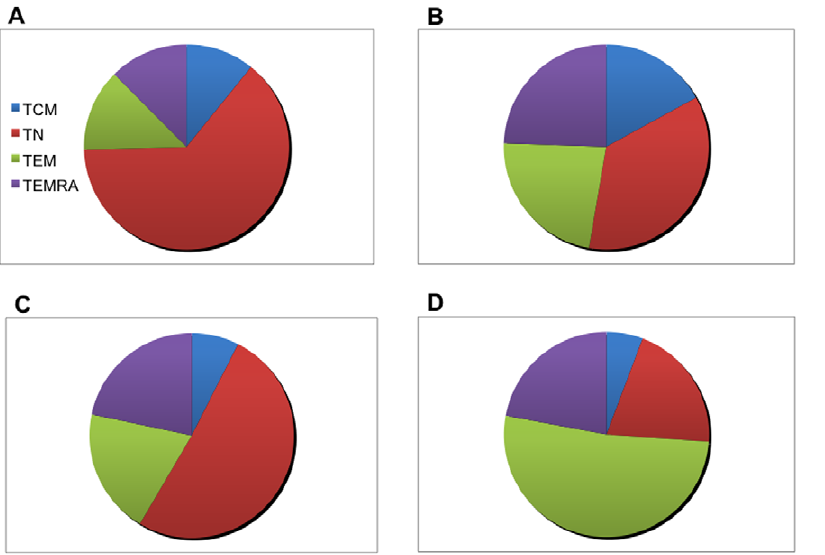
Figure 9. Proportion of resting and MSP1-specific IFN- c producing CD8 T cell subset in children compared to adults. Top left panel (A) shows the proportion of resting CD8 T cell subsets for children # 5 years old (from Fig. 4) with the lower left panel (C) showing the proportion of IFN- c producing CD8 T cell subsets in response to rMSP1 42 stimulation (from Fig. 7). Top right panel (B) shows the proportion of resting CD8 T cell subsets for adults $ 18 years old (from Fig. 4) with the lower right panel (D) showing the proportion of IFN- c producing CD8 T cell subsets in response to rMSP1 42 stimulation (from Fig. 7).